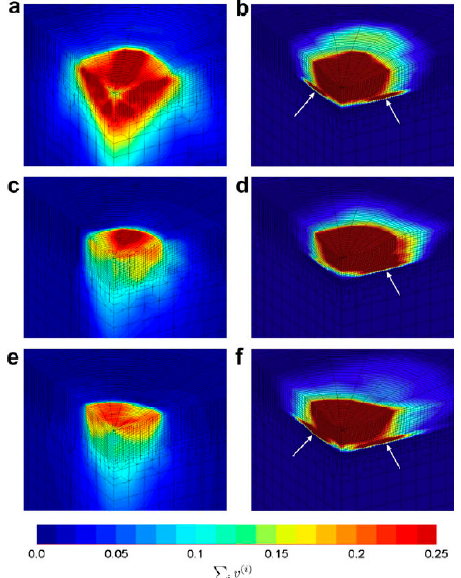
Figure 32. Details of the indentation-induced plastic zone in the simulations concerning face centered cubic (FCC) copper crystals. ( a , c , e ) correspond to the (001), (011) and (111) indented planes of bulk crystals. ( b , d , f ) correspond to their thin film counterparts. Plastic zone is assessed by considering the total acumulated plastic strain variable. White arrows point to the specific locations where high plastic strain localization occurs within the coating-substrate interface. Penetration depth in the figures is h s = 3.5 µ m [128]. Reproduced with permission from O. Casals et al., Computational Materials Science; published by Elsevier,